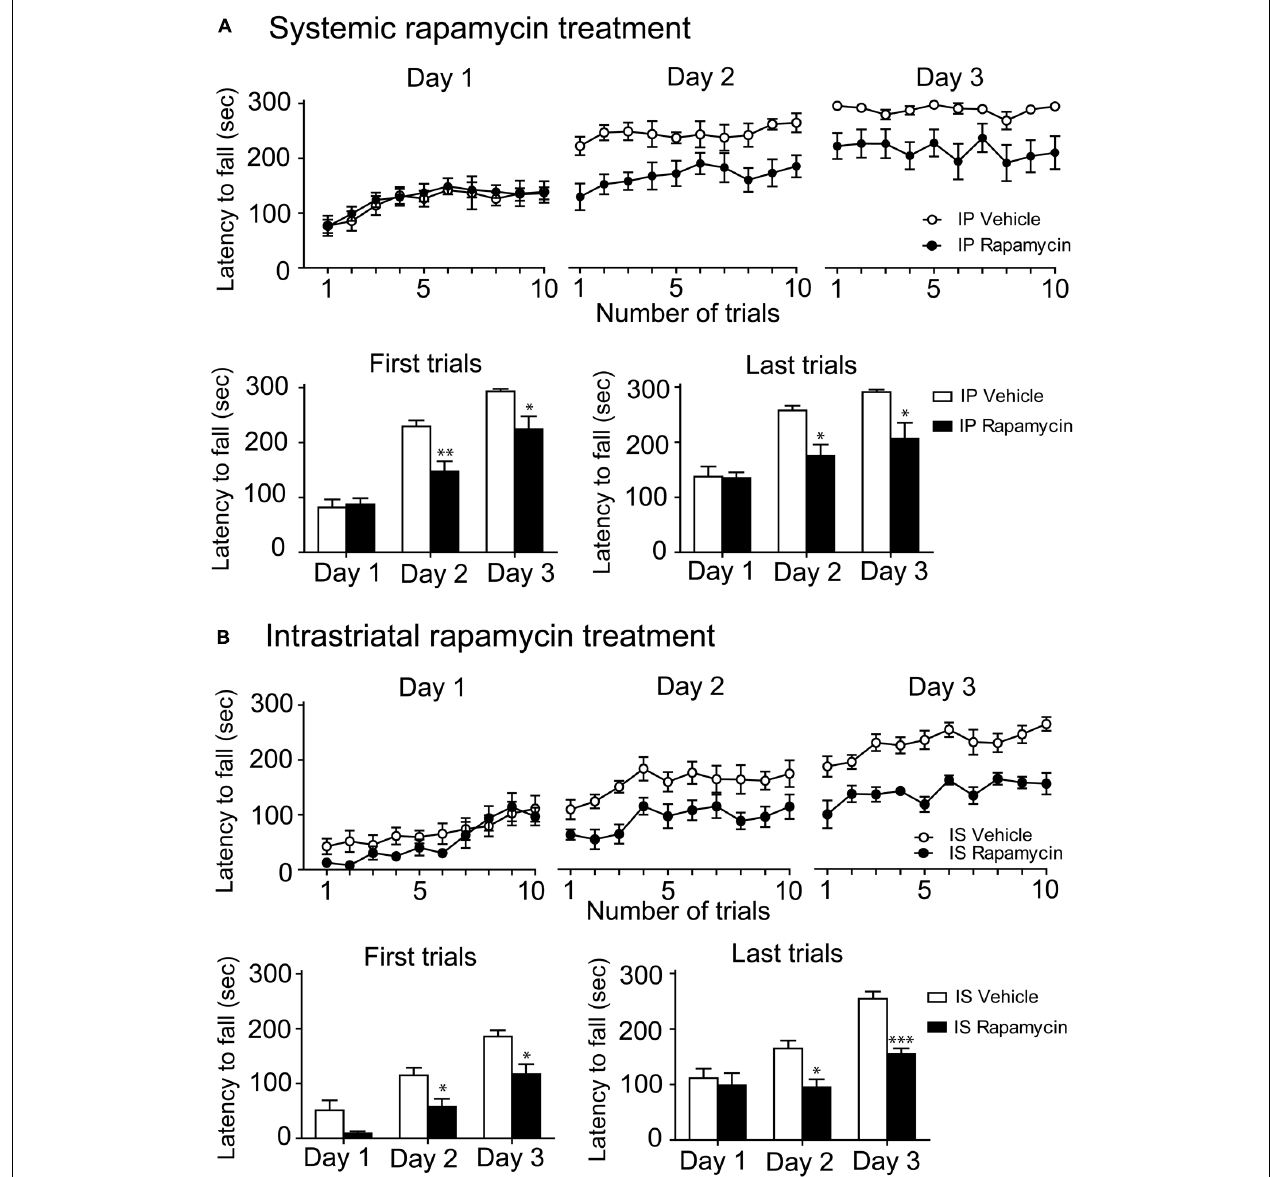
FIGURE 3 | Systemic and intrastriatal inhibitions of mTOR by rapamycin impaired motor learning. (A) Time spent by vehicle (DMSO) and intraperitoneal (IP) rapamycin-treated mice on the accelerating rotarod for each trial at days 1, 2, and 3. Rotarod learning was analyzed by pooling together the two first or the two last trials/training day of both groups.Values represent the average mean latency to fall expressed in seconds ± S.E.M, n = 8 vehicle-treated mice and n = 12 rapamycin-treated mice. ** P < 0.01